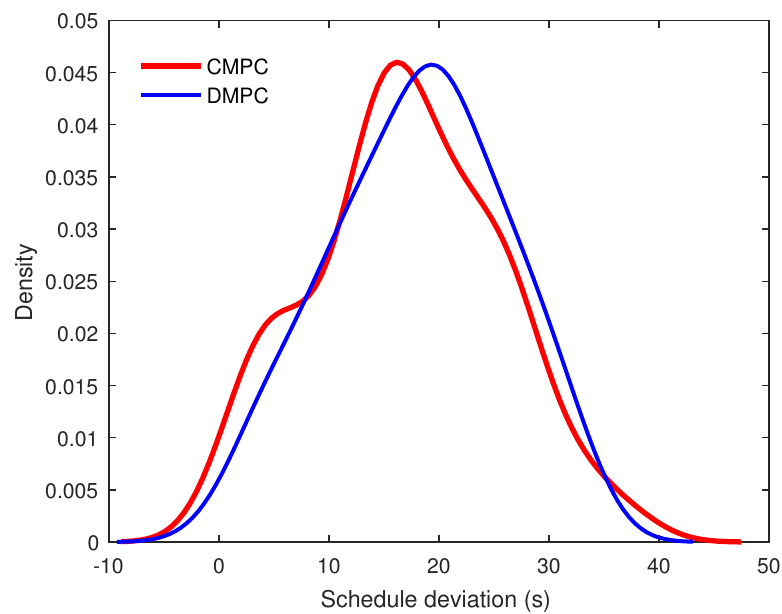
Figure 9. Distribution of schedule deviation under Case 2 and Case 3.